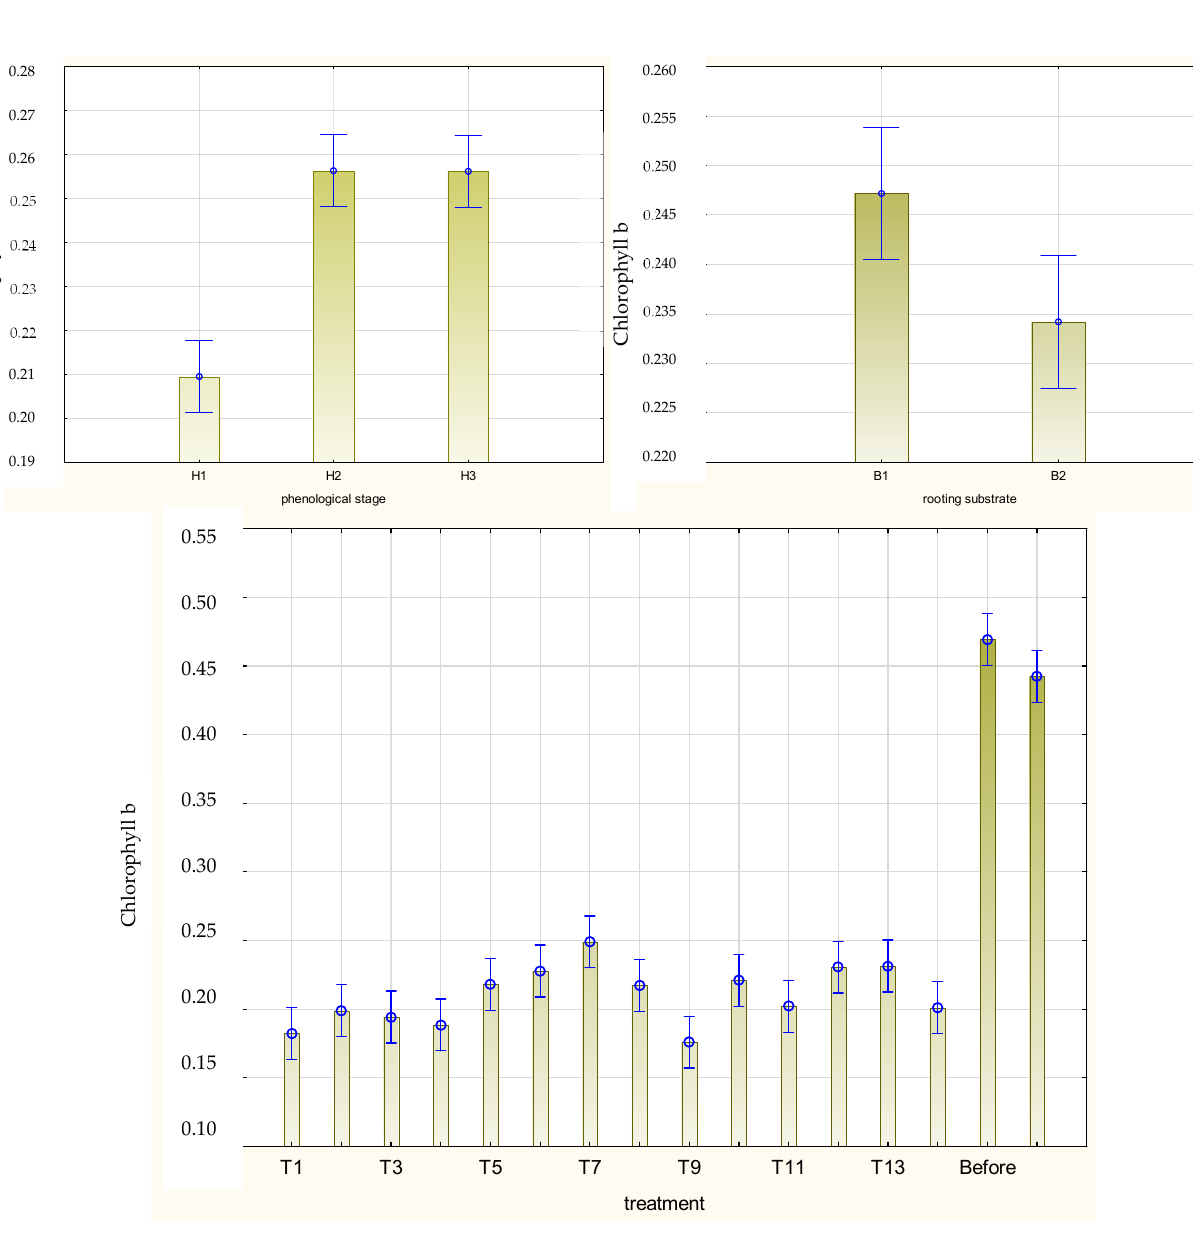
Figure 9. Content of chlorophyll b (mg·g − 1 FW) in leaves of Rosa ‘Hurdal’ cuttings prepared from three phenological stages (H1–H3) of shoots and rooted in two rooting substrates after treatment by rooting enhancers. B1—peat–perlite; B2—peat–sand; H1—flower buds closed (BBCH 54,504; flower buds still closed); H2—flowers opened (69,605; full flowering, at least 50% of flowers open); H3— immediately after petal shedding (69,629; end of flowering of second order stem: all petals fallen); and treated: T1—the control cuttings; T2—0.4% IBA (Ukorzeniacz A aqua ); T3—0.2% NAA (Ukor- zeniacz B aqua ); T4, T5, T6, T7, T8, T9—Algae Extract: watering with 0.4% or 0.6% Bio Rhizotonic (10 mL) 1, 2, or 3 times (after planting and 10 and 20 days later); T10, T11, T12—Organic Preparation— watering with 0.1%, 0.2%, or 0.4% Root Juice™ (10 mL) after planting; T13, T14—Plant Extract— watering with 0.012% or 0.02% Bio Roots (10 mL) after planting. The degree of rooting on a 5-point scale: 1—only a callus, without formed roots; 2—at least one short root; 3—a few longer roots; 4— roots visibly developed, differentiated by the length; 5—strong roots starting to form a root ball, well developed. Vertical bars denote 95% confidence intervals for the mean of counts (one-way ANOVA).